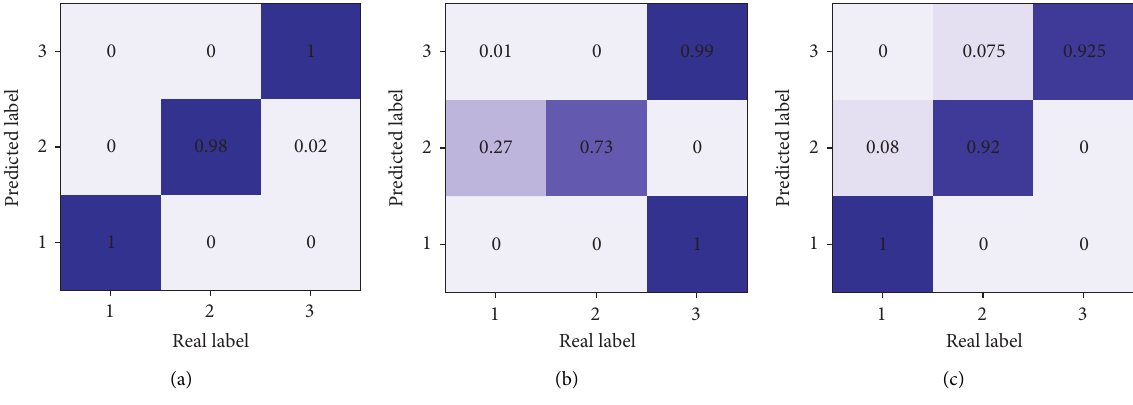
Figure 12: Clustering accuracy of CWRU data sets. (a) ATDPS; (b) K-means; (c) Figure 9. The classification accuracy of the different algo- rithms is shown in Figure 10.